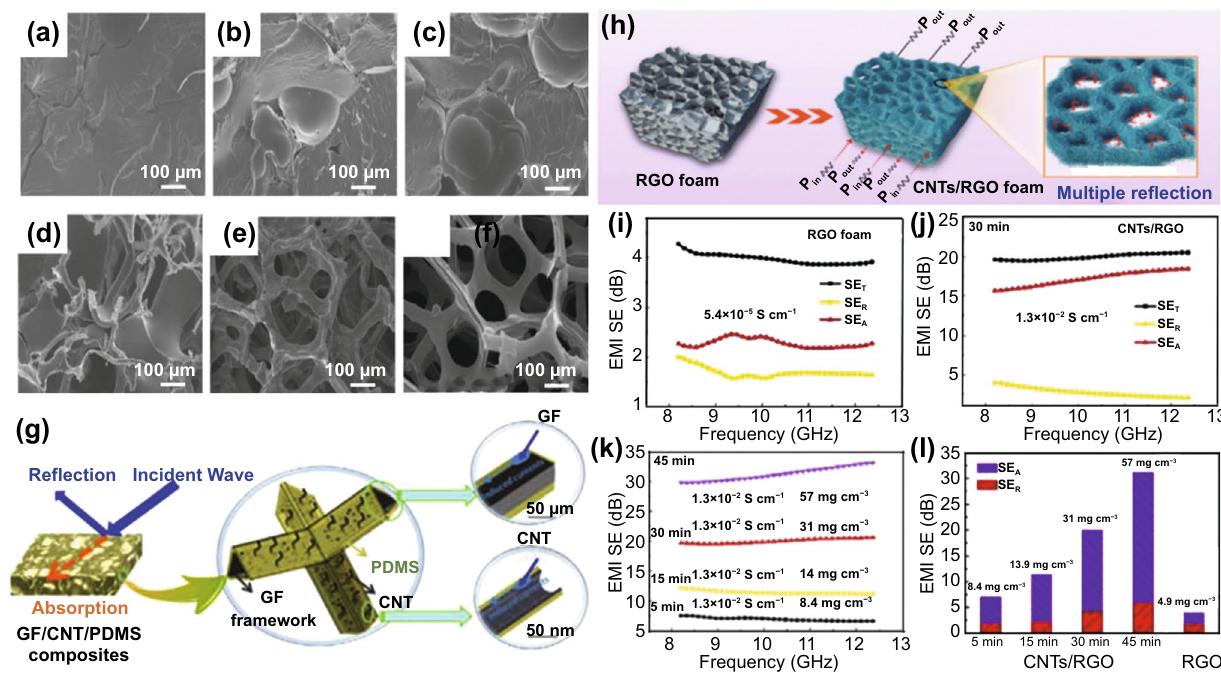
Fig. 8 a-e SEM images of GF/PDMS composites with porosities of 9.3%; 28.9%; 51.5%; 73.2%; 90.8%. f SEM image of graphene layers after deposition on a Ni substrate. g Schematic illustration of effective EMI shielding by GF/CNT/PDMS hybrid composites through reflection and absorption [119]. Copyright © 2016 Elsevier Ltd. h Schematic illustration of the EMI shielding mechanism of CNTs/RGO foam composite. i, j SE T , SE A and SE R of the RGO and CNTs/RGO foam composites. k SE T , conductivity and density of CNTs/RGO foam composite with different reaction time. l The mean values of SE A and SE R of RGO and CNTs/RGO foam composite with different reaction time [116]. Copyright ©